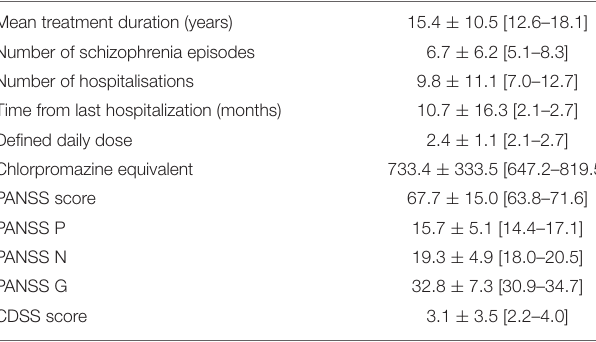
TABLE 2 | Clinical aspects of schizophrenia